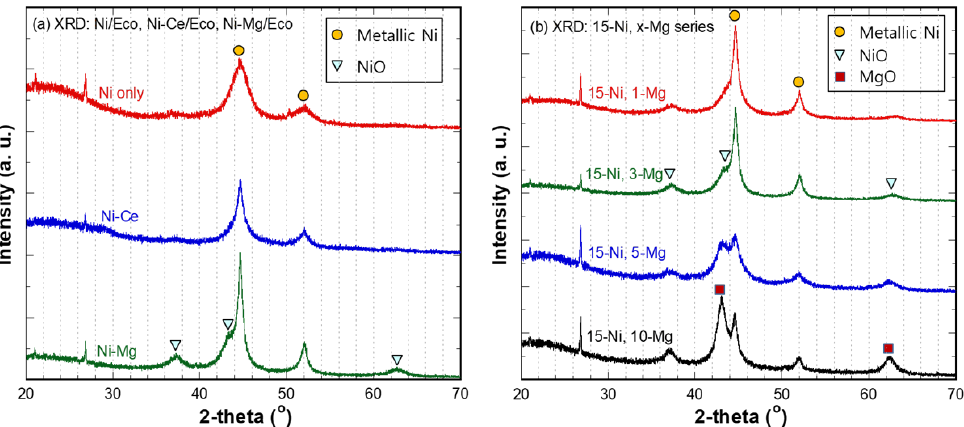
Figure 6. X-ray diffraction (XRD) patterns of ( a ) Ni/Eco, Ni-Ce/Eco, and Ni-Mg/Eco and ( b ) 15-Ni, x-Mg series (Ni metal: PDF# 00-004-0850, NiO: PDF# 00-004-0835, and MgO: PDF# 01-071-6452).